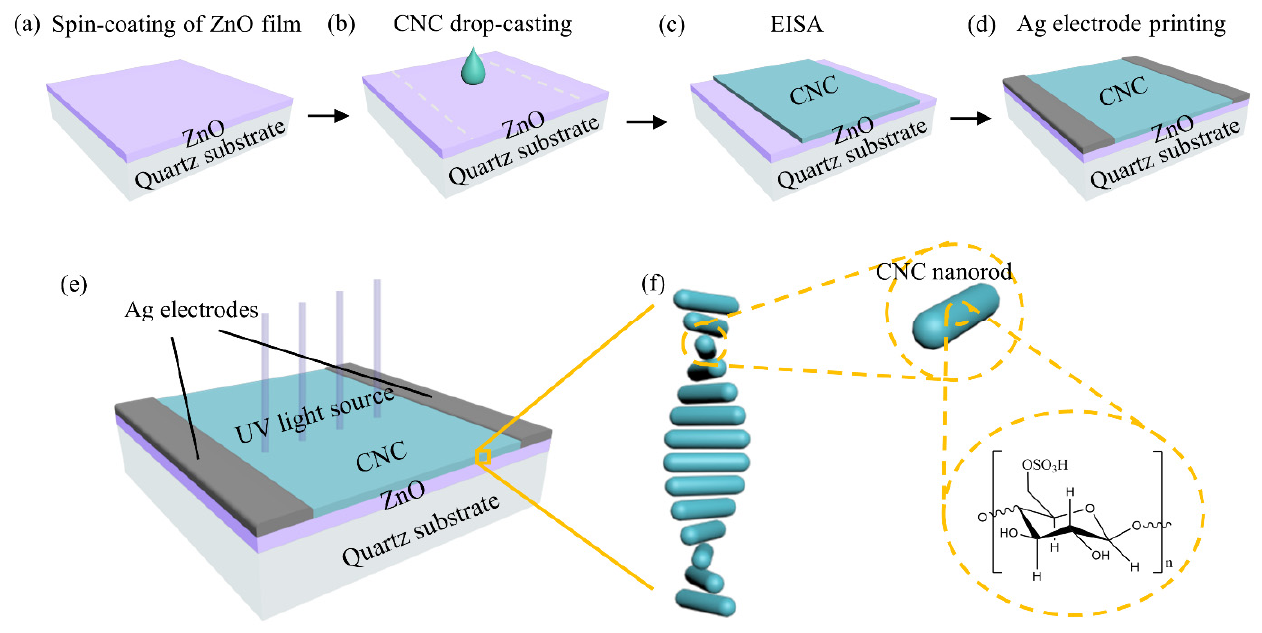
Figure 1. ( a – d ) Fabrication flow of the CNC/ZnO CPL photodetector. ( e ) Schematic of CNC/ZnO CPL photodetector. ( f ) Chiral nematic ordering of CNC layer.